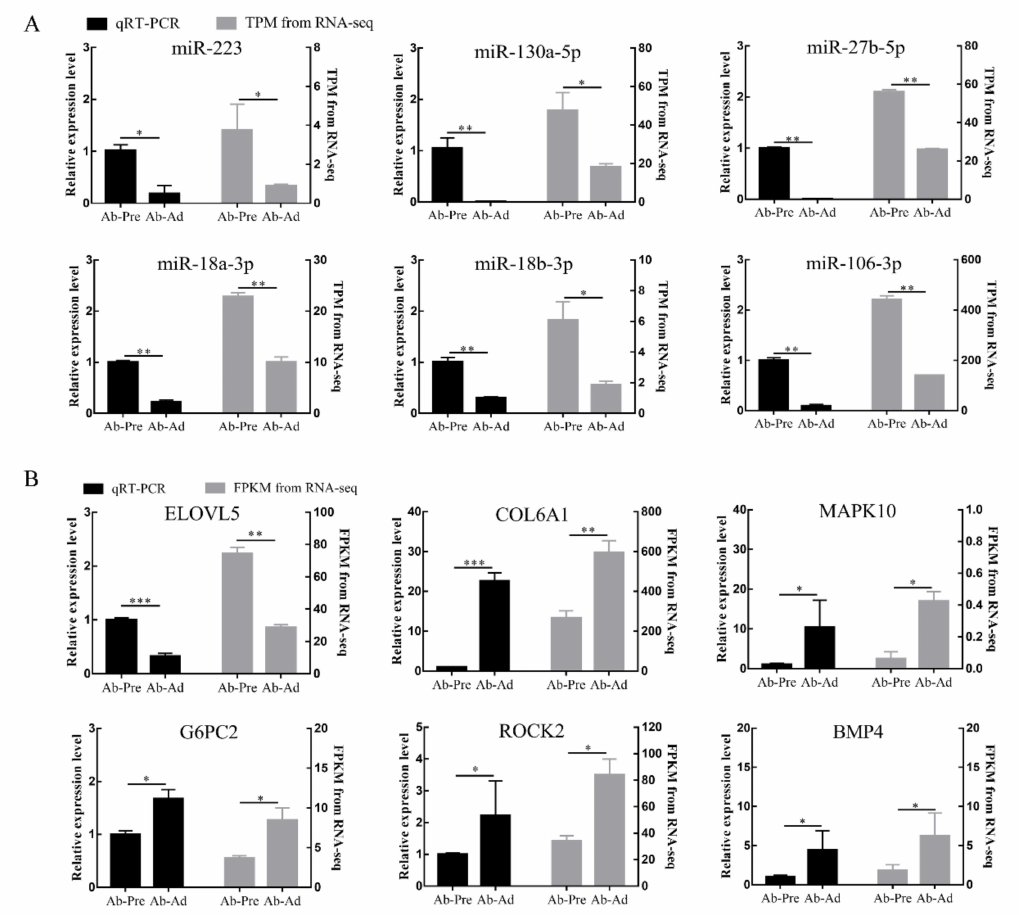
Figure 3. Verification of the accuracy of sequencing results by qRT-PCR. ( A ) Validation results of miRNAs. ( B ) Validation results of mRNAs. The data are demonstrated as the means ± SEM; * means p < 0.05, ** means p < 0.01, *** means p <